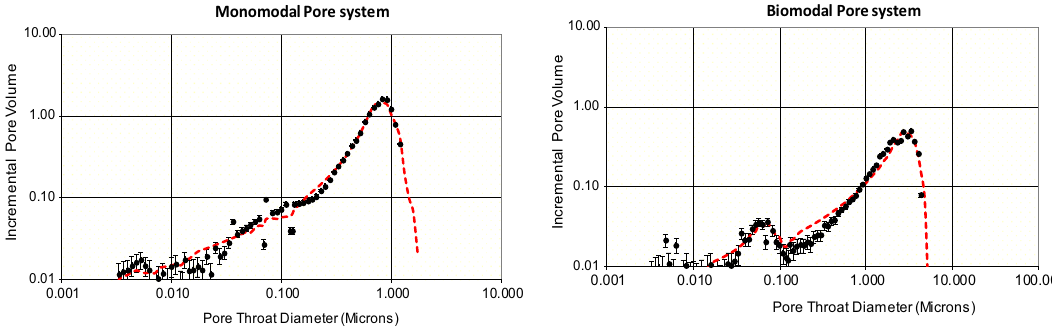
Fig. 5 Histograms of pore-throat diameter from MICP data (Black dots) along with pore-throat histograms from Thomeer hyperbola (read line); it shows a typical unimodal pore system (left), and a typical bimodal pore system